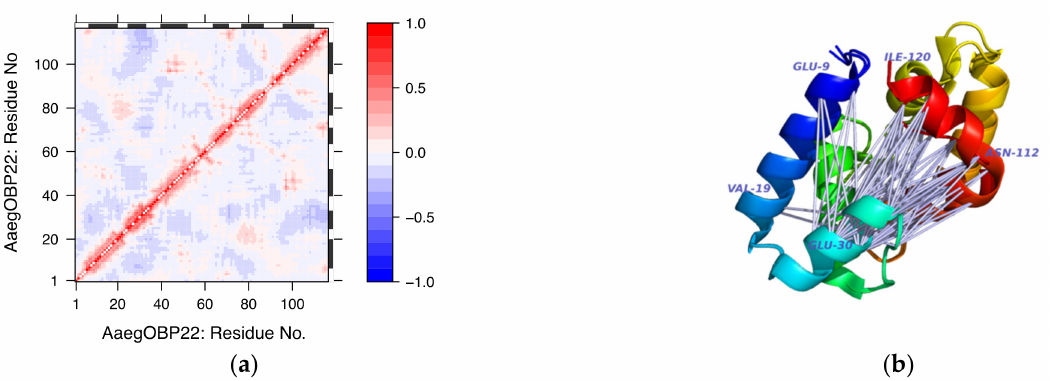
Figure 10. Pairwise residue cross-correlations of AaegOBP22. The cross-correlation matrices were calculated from the complete set of modes. The atomic fluctuations within a system are reflected in the magnitude of all pairwise cross-correlation coefficients for atoms i and j. Correlated fluctuations imply that atoms i and j fluctuate with the same period and phase, whereas anticorrelated fluctuations imply that atoms i and j fluctuate with the same period but opposite phase (Panel a ). Visualisation of residues showing anticorrelated motions on the superposed structures of the AaegOBP22 in ligand-free and ligand-bound conformations. Correlated motions are not shown (Panel b ).